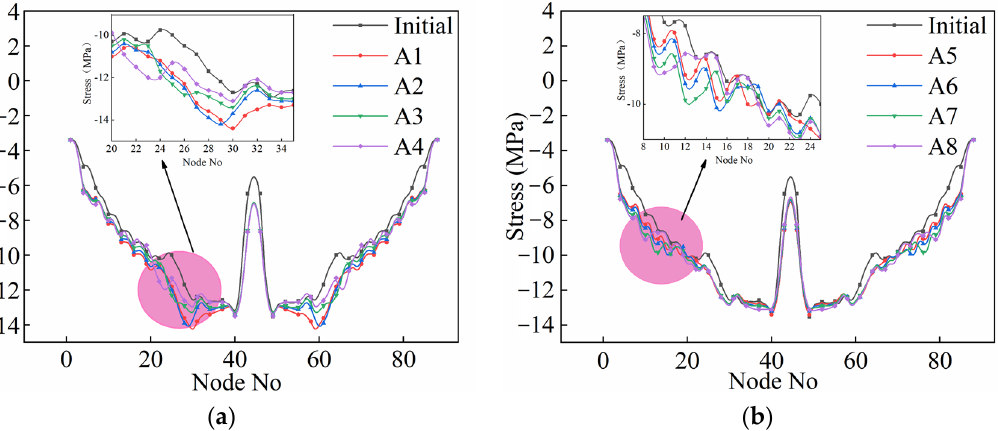
Figure 11. The stress change of the main beam when A1-A8 fracture, respectively. ( a ) Fracture stress distribution of A1–A4; ( b ) fracture stress distribution of A5–A8. distribution of A1–A4; ( b ) fracture stress distribution of